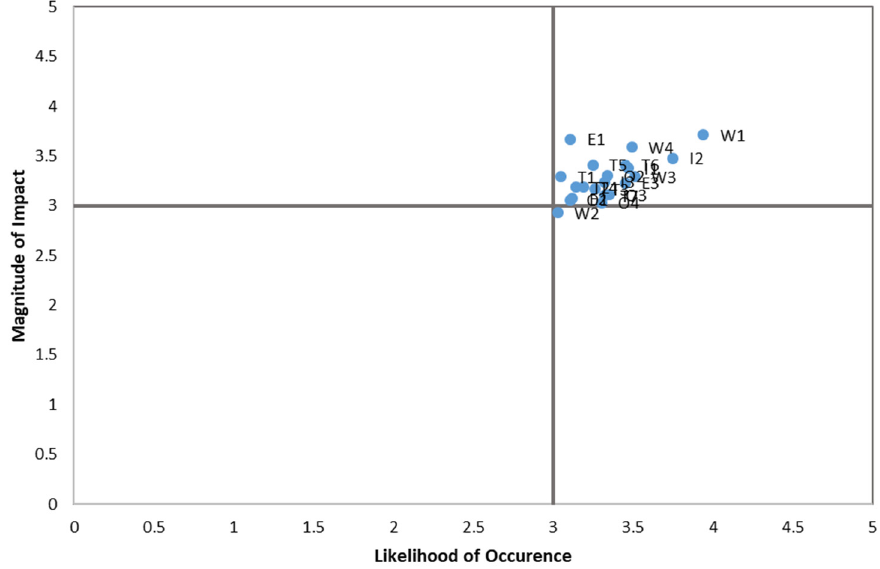
Figure 4. ImT implementation risk matrix.